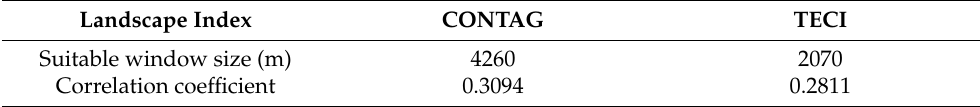
Table 9. The suitable window of CONTAG and TECI. Landscape